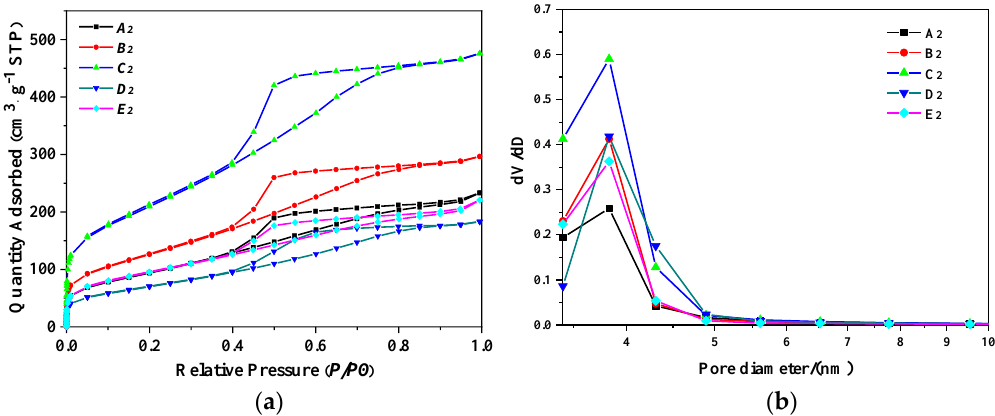
Figure 8. ( a ) N 2 adsorption–desorption isotherm results of PB with di ff erent rotating speeds of CF-RPB, ( b ) pore size distribution of PB with di ff erent rotating speeds of CF-RPB (concentration of NaAlO 2 solution, 0.1 mol / L; gas–liquid ratio, 3:1).